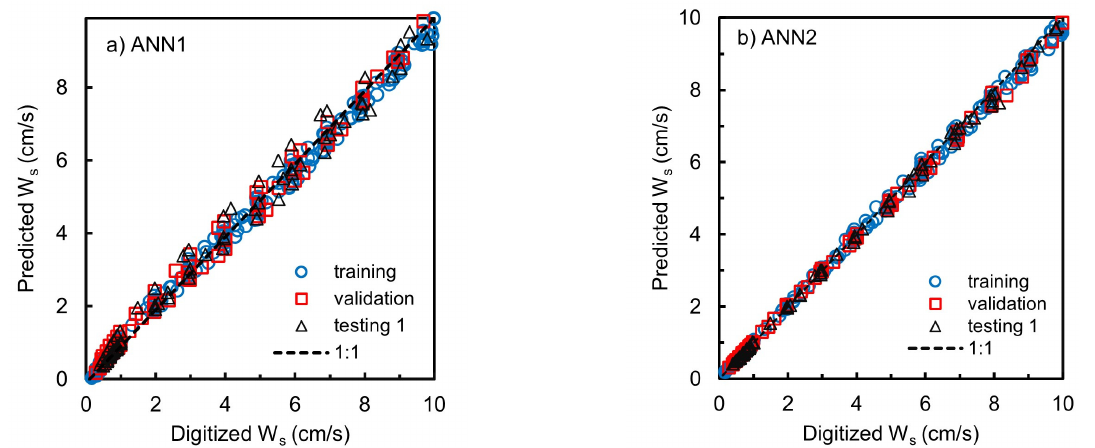
Figure 5. Scattering plot for results of training, validation, and testing 1 of ANN1 ( a ) and ANN2 ( b ) for W s lower than 10 cm/s.